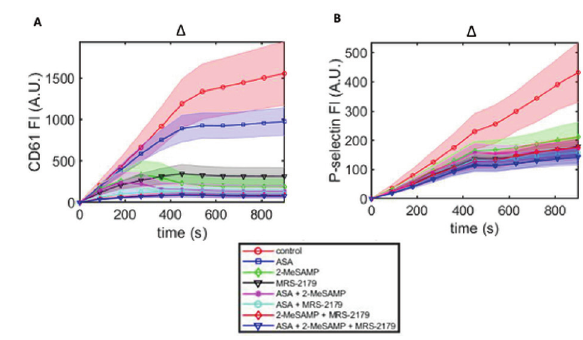
Fig. 2 Quantitative fl uorescence data from ► Fig. 1 . PPACK WB with and without ASA, 2-methylthio (Me)-SAMP, and MRS-2179 was per- fused over collagen at 100/s for 7.5minutes, then fl ow was stopped for 7.5minutes. Platelet (A) and P-selectin (B) fl uorescence intensities were measured throughout the course of the experiment amongst the different conditions. Delta signi fi es change from 100 to 0/s fl ow rate at 7.5minutes. (N ¼ 3 donors, n ¼ 6 clots for each panel; AU ¼ arbitrary units). ASA, acetylsalicylic acid; WB, whole blood.